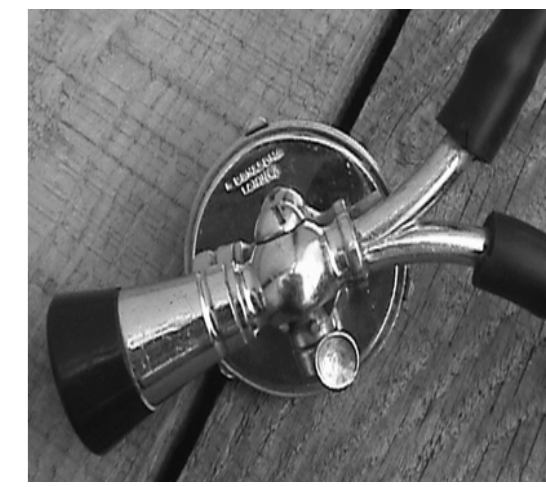
Figure 1. Ford-Bowles Stethoscope. Note the large and narrow bell that allows the identification of murmurs while performing peri- pheral vascular auscultation. This modern version is accompanied with a diaphragm to complement the auscultation of other sys- tems for a thorough physical examination.